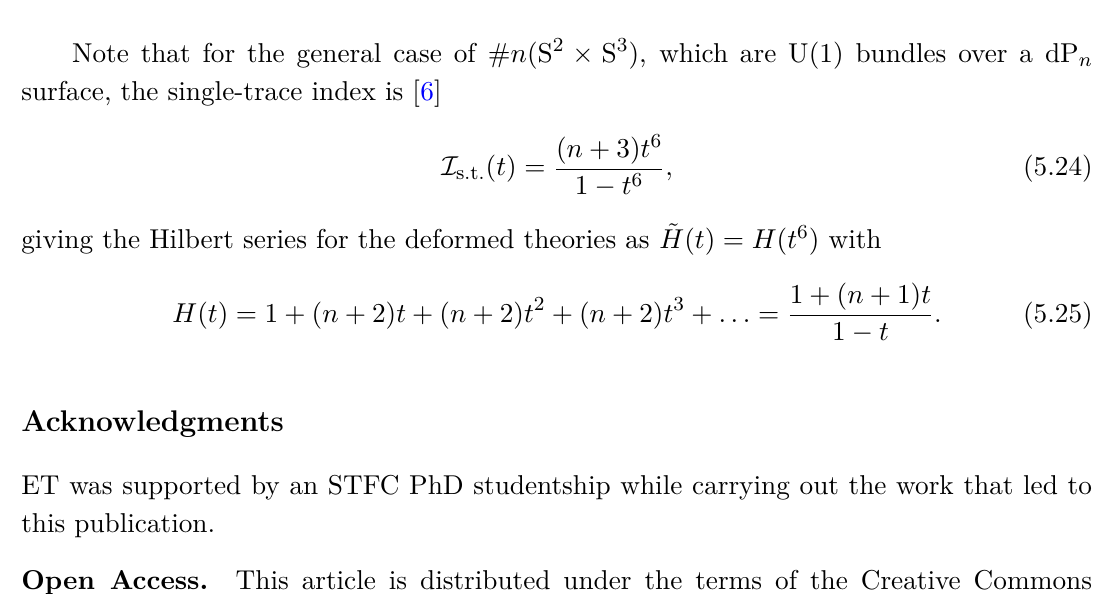
Table 3 . Counting of operators in field theory dual to #6( S 2 × S 3 ) graded by k . Note that the number of tr( W α W α O ) operators, except for the case of k = 0 , is the same as the number of tr( O ) operators after a shift of k by 3. There are seven modes for tr( W α W α O ) at k = 3 since b 2 + 1 = 7 for #6( S 2 × S 3 )